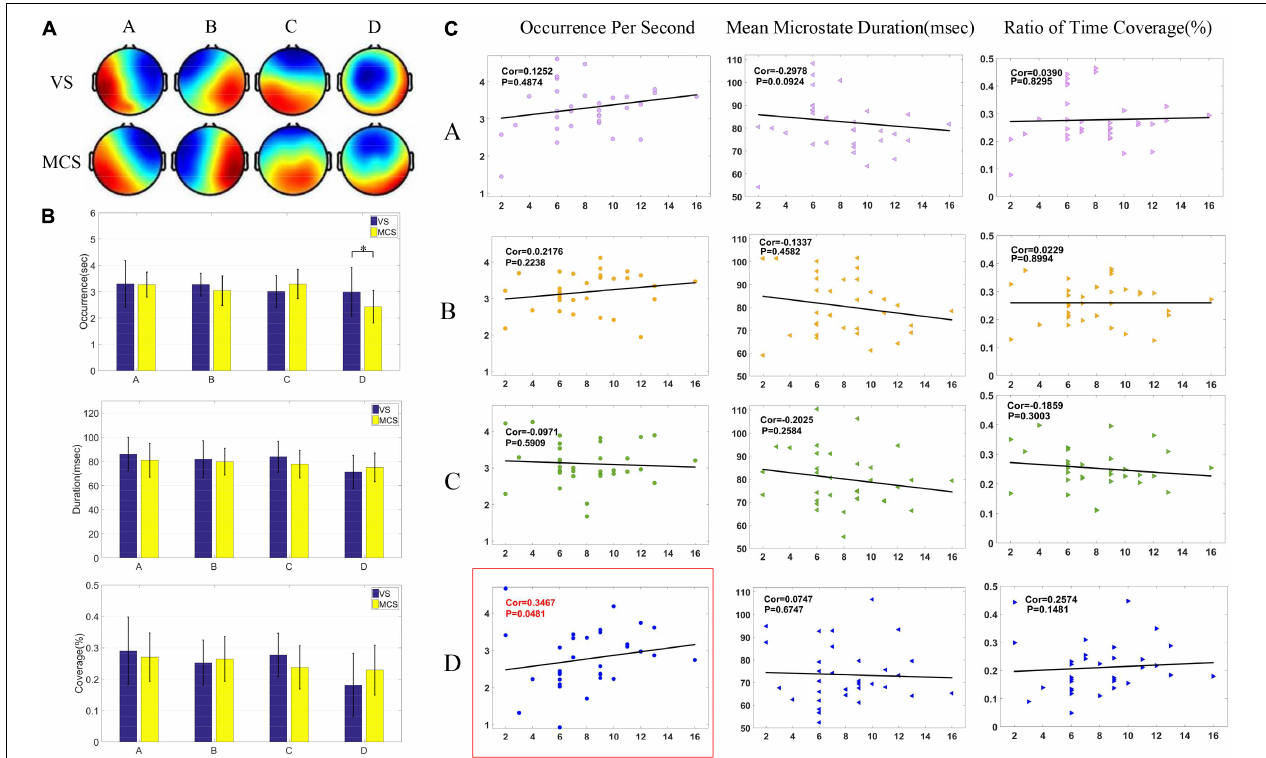
FIGURE 1 | Microstates of patients with DOC before HD-tDCS treatment. (A) Microstate topographic map of patients in the VS group and MCS group before the treatment. (B) Comparison of three microstate parameters (OPS, MMD, and Cov) between the VS group and MCS group under four microstates by two-tailed t -test. There was a significant difference in OPS in microstate D between the two groups ( p = 0.0425). (C) Pearson correlation between pretreatment microstate parameters and CRS-R scores in patients with DOC. Significant correlations ( p < 0.05) were indicated in red and circled in red (Cor = 0.3467, p =